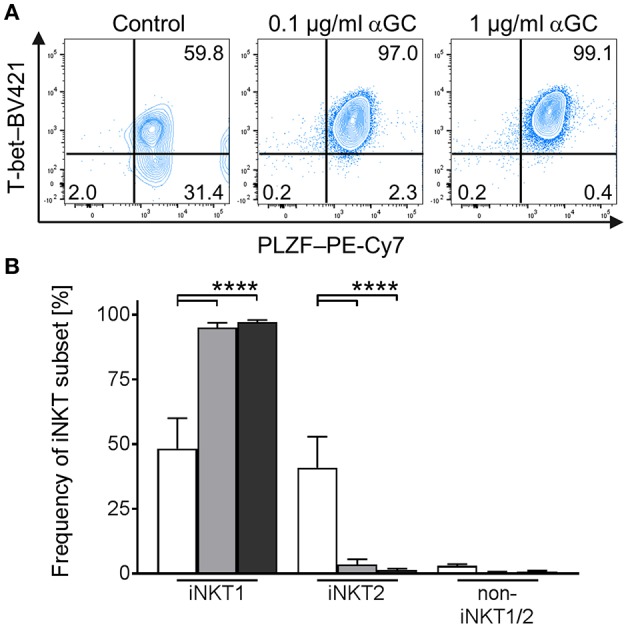
Differentiation of activated porcine iNKT cells. Porcine PBMC were cultivated in the presence of αGC or DMSO as vehicle control. Intracellular expression of T-bet and PLZF was analyzed by flow cytometry after stimulation for 4 days. (A) Representative plots of T-bet/PLZF co-expression in untreated control iNKT cells (left) and iNKT cells stimulated with 0.1 μg/ml (middle) or 1 μg/ml (right) αGC. (B) Frequency of iNKT1, iNKT2, and non-iNKT1/2 upon stimulation with 0.1 μg/ml (gray) or 1 μg/ml (black) αGC or DMSO as vehicle control (white) (n = 6). Data shown as mean (SD), ****p < 0.0001, repeated-measures one-way ANOVA with Holm-Sidak's post-hoc test for multiple comparisons.